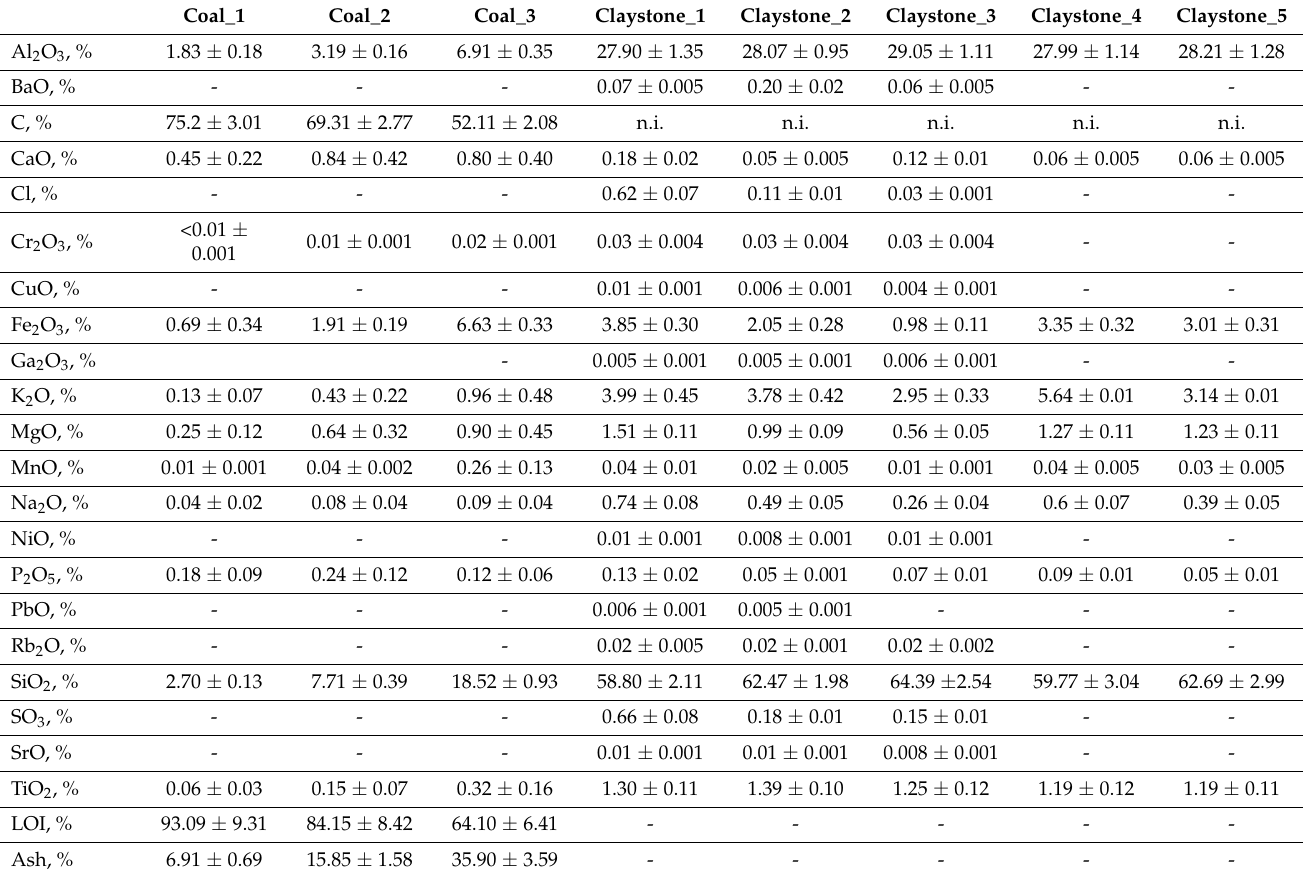
Table 2. Results of the chemical composition analysis of the coals and claystones